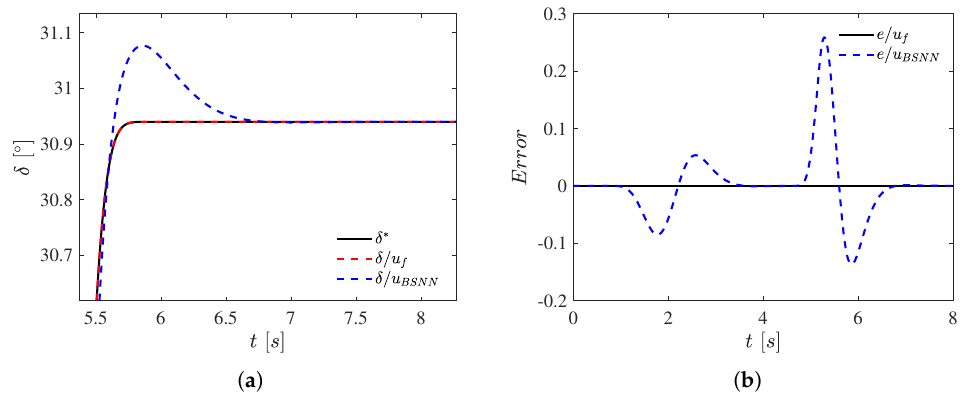
Figure 4. SMIB system: ( a ) zoom of δ when the reference value is increased; ( b ) tracking error, e = δ − δ ∗